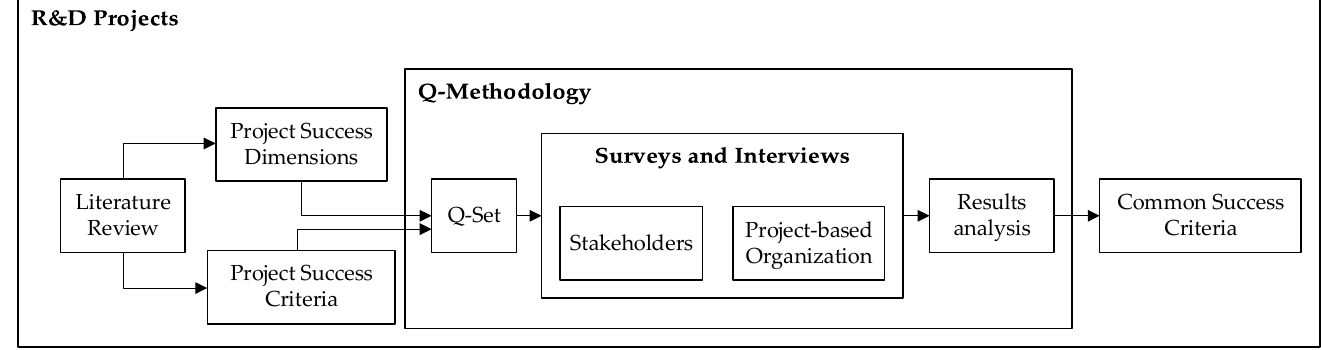
Figure 3. Conceptual framework.